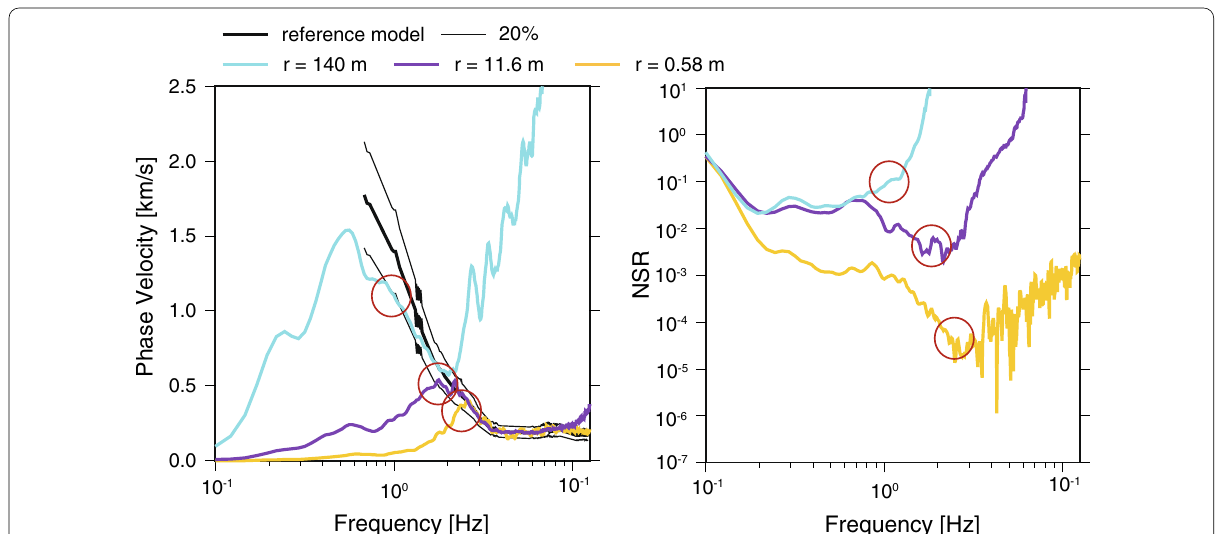
Fig. 9 Readings (circles) of the phase velocities (left) and NSRs (right) at the upper limits of the analyzable frequency range. Three cases of array radius of 0.58 m (yellow), 11.6 m (purple), and 140 m (sky blue) are shown as an example. In the left panel, the reference model (black line) and the 20% levels (thin black lines) are also ±